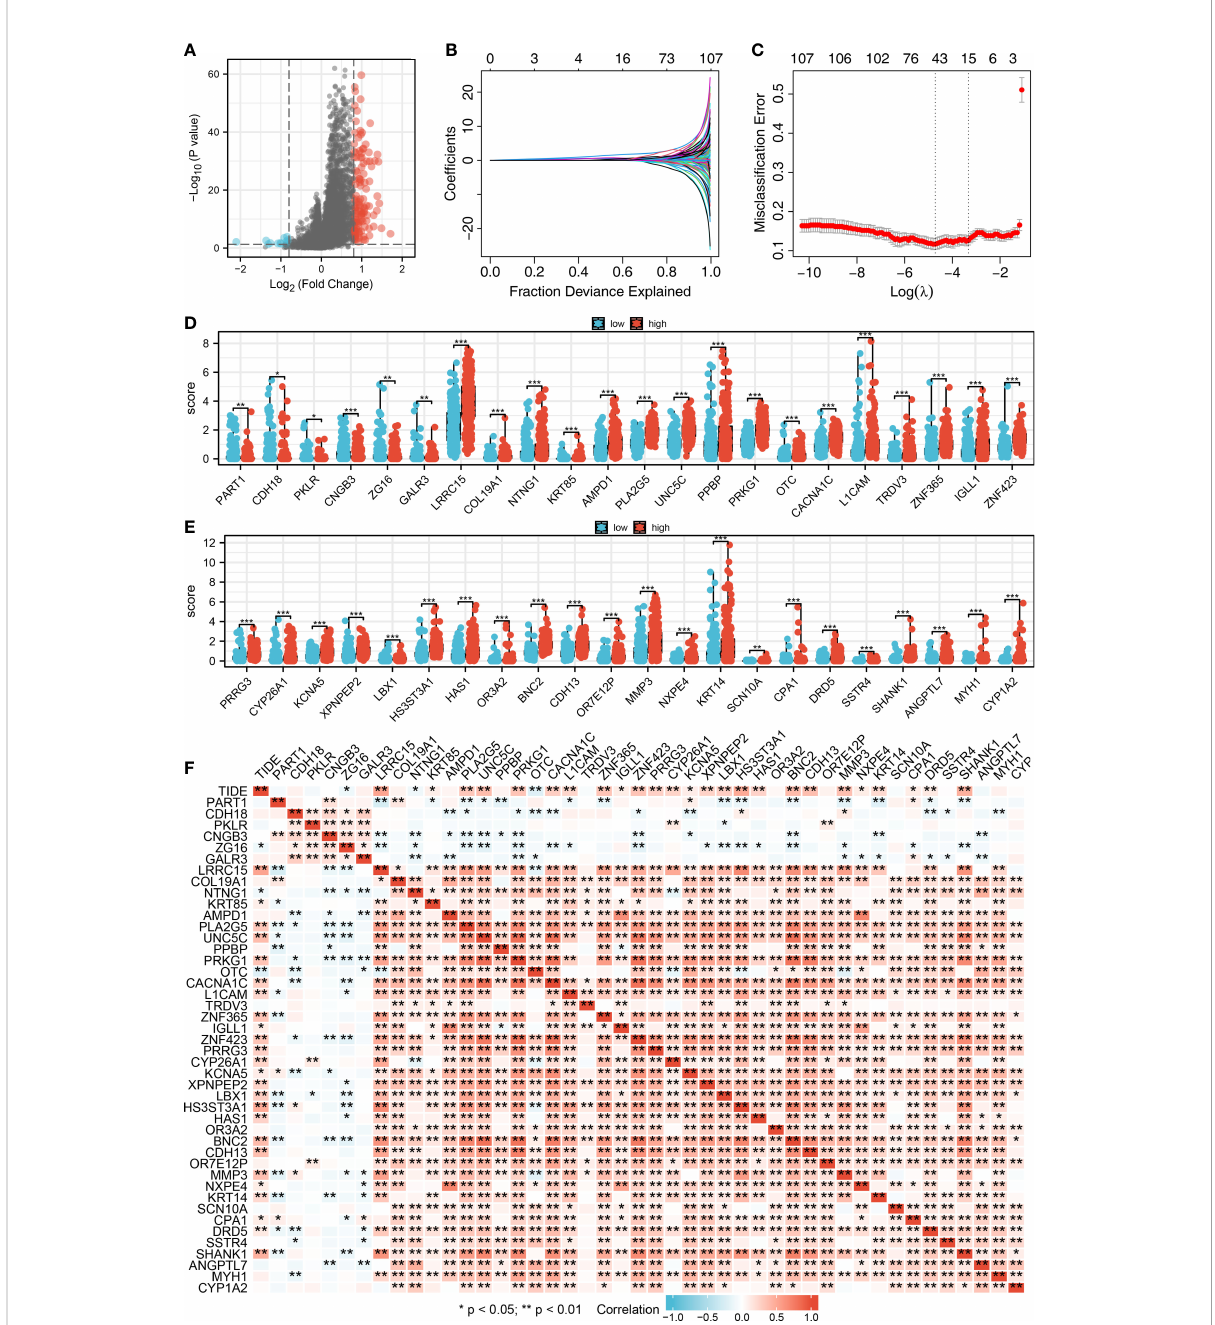
FIGURE 3 Identi fi cation of characteristic molecules of lung cancer immunotherapy. (A) The volcano map demonstrated the differential expressed genes between high- and low-CAFs groups; (B-C) Logistic lasso regression; (D-E) The expression level 44 CAF characteristic genes in patients with high- and low-CAFs in fi ltration, *P < 0.05, **P < 0.01, ***P < 0.001; (F) The correlation analysis between 44 CAF-related signatures and TIDE score, *P < 0.05, **P <